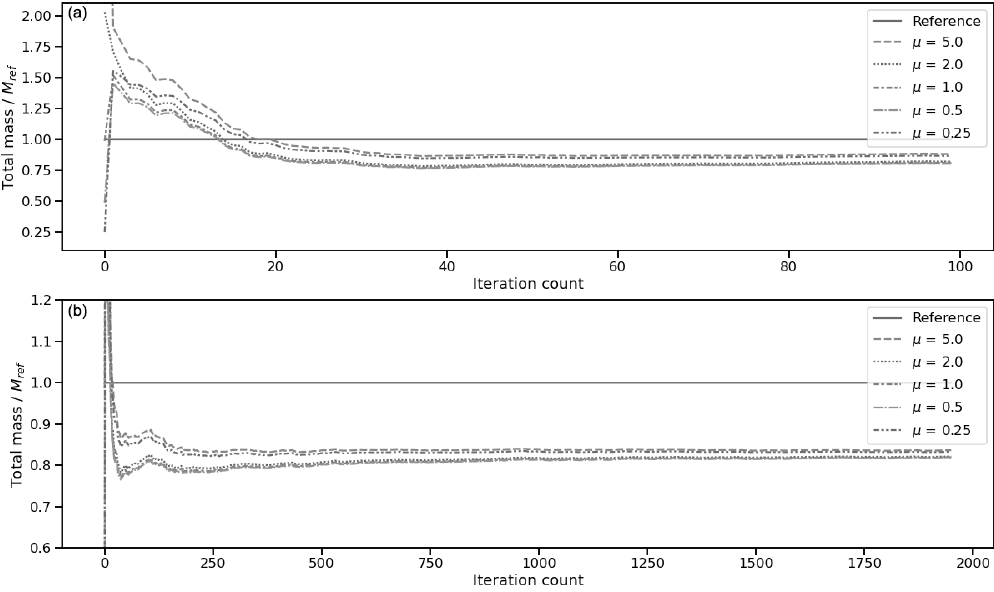
lead to better estimations of the total mass and concentration field after some time as one might expect (Fig. 7 and Table